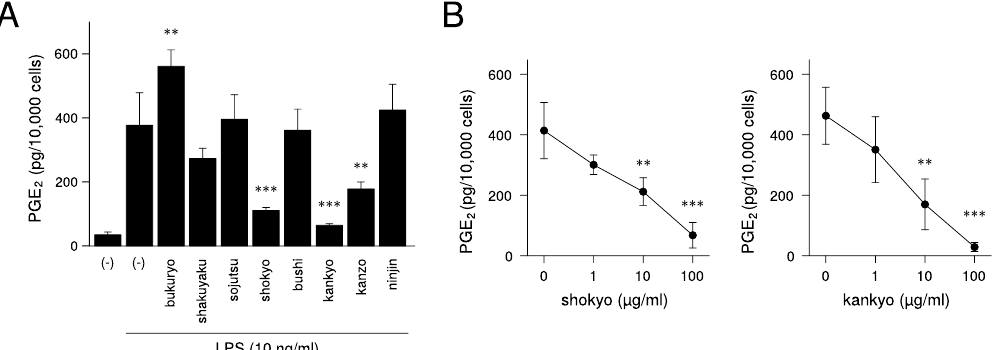
Figure 3. The effect of herbs in kakkonto (TJ-1) on PGE 2 production: This figure is cited from Ara and Sogawa [29] (CC-BY-4.0) and modified for this review.